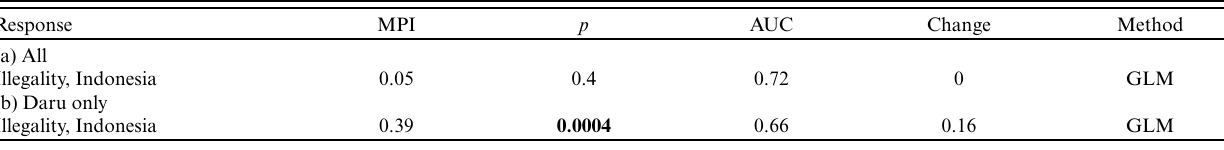
Table 4 . Regression models that tested the relationship between household-level illegality against multidimensional poverty index (MPI) for (a) all households and (b) Daru only. The table shows the MPI parameter estimate and significance. All models (except that for Daru only) included village as a fixed effect. The p value is for the ANOVA of the additional variance explained by adding the MPI variable to the nested model that included place only. Bold indicates a statistically significant relationship (p ≤ 0.05).